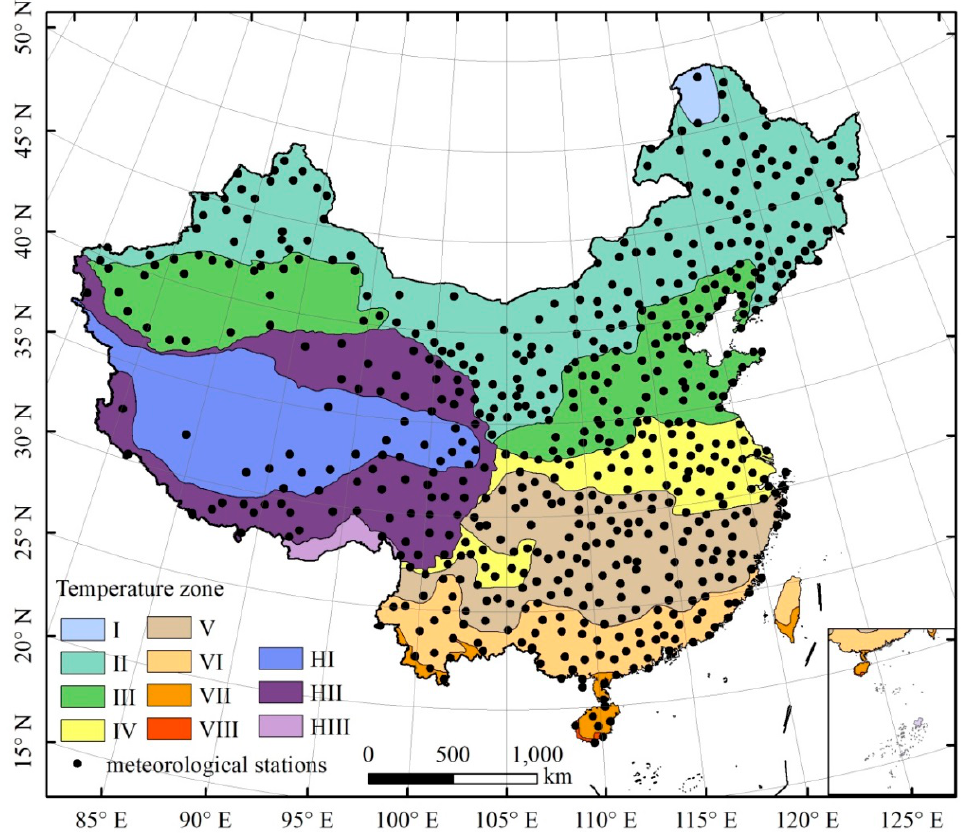
Figure 1. Sketch map of climate zones over mainland China (revised from [20]). I–cold temperature zone, II–mid-temperate zone, III–warm temperate zone, IV–north subtropical zone, V–mid-subtropical zone, VI–south subtropical zone, VII–marginal tropical zone, VIII–mid-tropical zone, HI–plateau sub-frigid zone, HII–plateau temperate zone, HIII–plateau subtropical mountains.